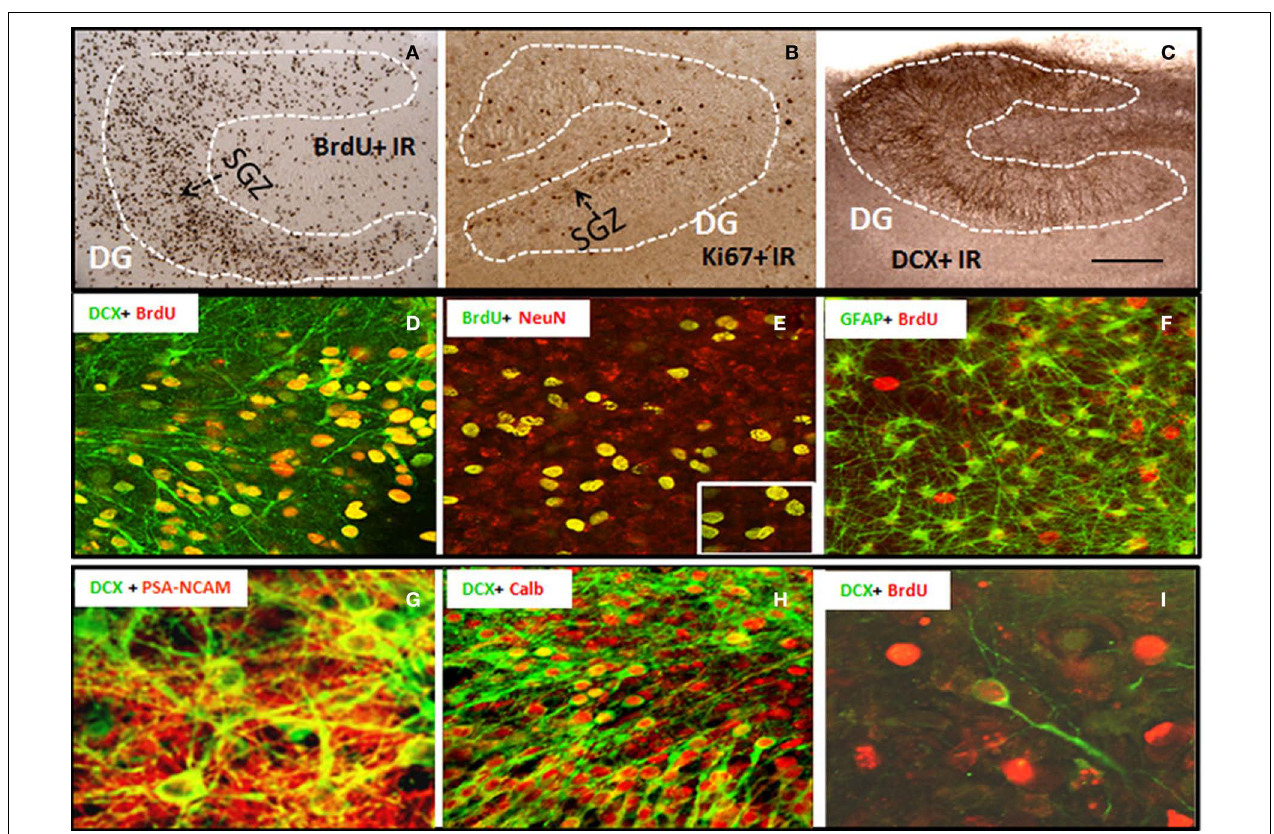
marker NeuN at 14 DIV (original magnification 20 × , insert-80 × ); and (F) a merger image of double immunofluorescent staining with BrdU (red) and astrocyte marker GFAP (green), indicating a rare colocalization of BrdU + cells with GFAP + astrocytes (original magnification 20 × ). Shown in the bottom panel are representative confocal images showing (G) DCX + cells (green) coexpressing PSA-NCAM (red, a marker for young neurons, original magnification 120 × ); (H) a majority of DCX + cells (green) coexpressing calbindin (red, a marker for mature neurons, original magnification 20 × ); and (I) in vitro -labeled BrdU + cells (red) and DCX + IR (green) indicating that in vitro -labeled BrdU + cells occasionally become DCX + neurons under the culture conditions used (original magnification 120 ×